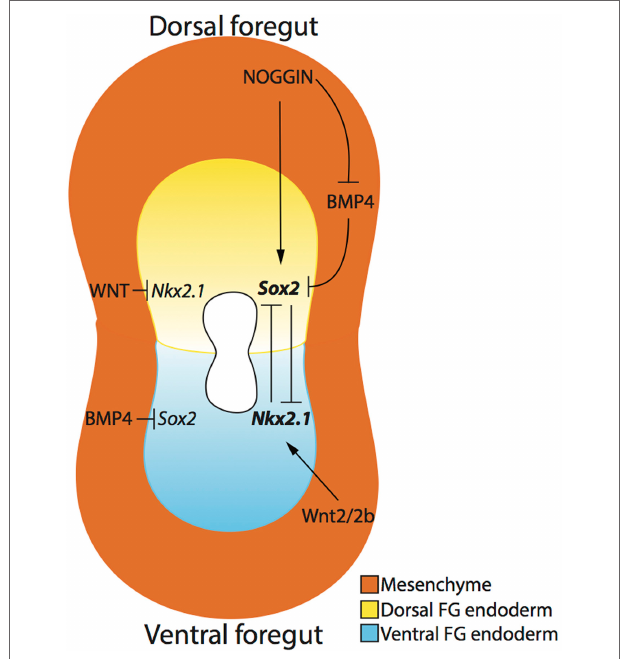
FiGURe 3 | Dorsoventral patterning of the developing foregut endoderm . The dorsal (yellow) and ventral (blue) endoderm express Sox2 and Nkx2.1 , respectively. NOGGIN, produced by the surrounding mesenchyme (orange), regulates the expression of Sox2 in the dorsal foregut endoderm by directly activating Sox2 expression and indirectly inhibiting BMP4, which in turn inhibits Sox2 . Ventrally, Wnt2/2b signaling activates the expression of Nkx2.1 in the ventral foregut endoderm, and WNT signaling also inhibits Nkx2.1 expression in the dorsal foregut endoderm. The mutual inhibition activity of Nkx2.1 and Sox2 create an expression gradient of these two genes, thereby allowing the separation of the two